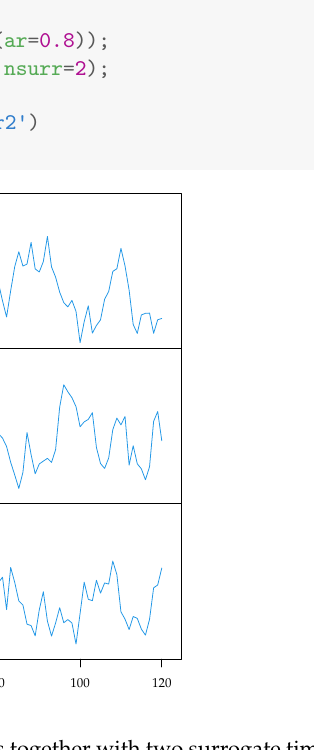
Figure 9. Time series from a AR(1) process together with two surrogate time series generated through Simulated